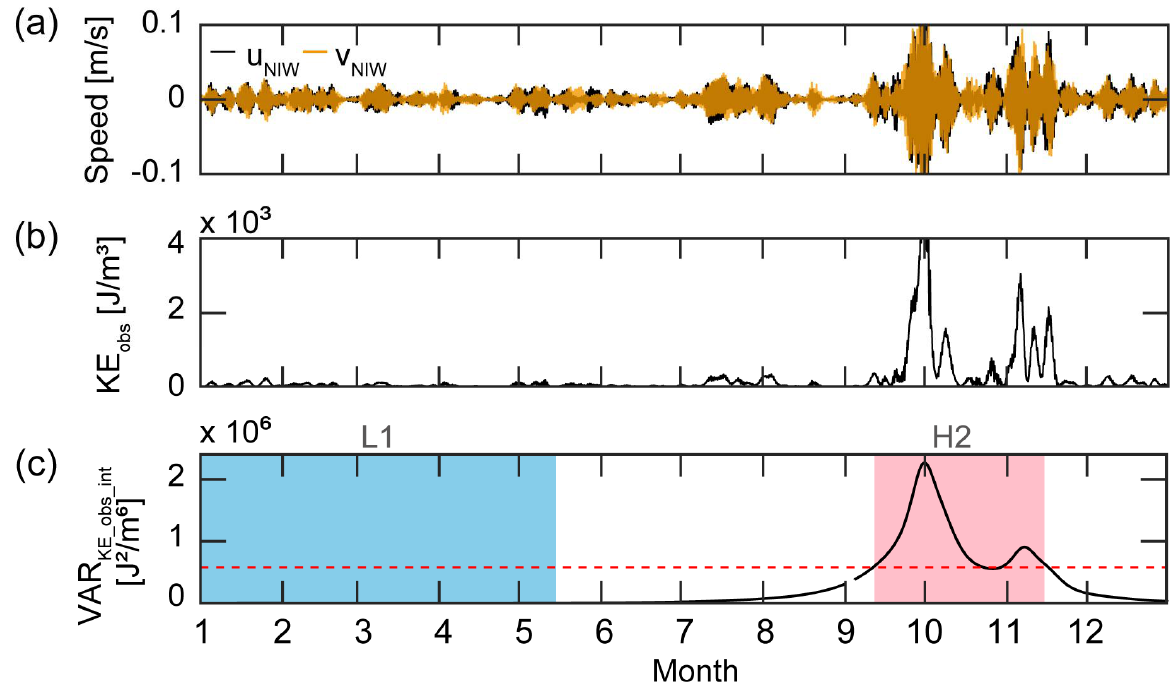
Figure 5. Time series of ( a ) zonal ( u NIW , black line) and meridional ( v NIW , orange line) components of horizontal NIW oscillations, ( b ) KE NIW_obs , (c) VAR NIW_obs_int at 400 m in 2003 as an example. Red and blue shaded boxes and no shade in ( c ) indicate period high (H2), period low (L1), and period neutral, respectively. Red dashed line in ( c ) indicates σ + μ .